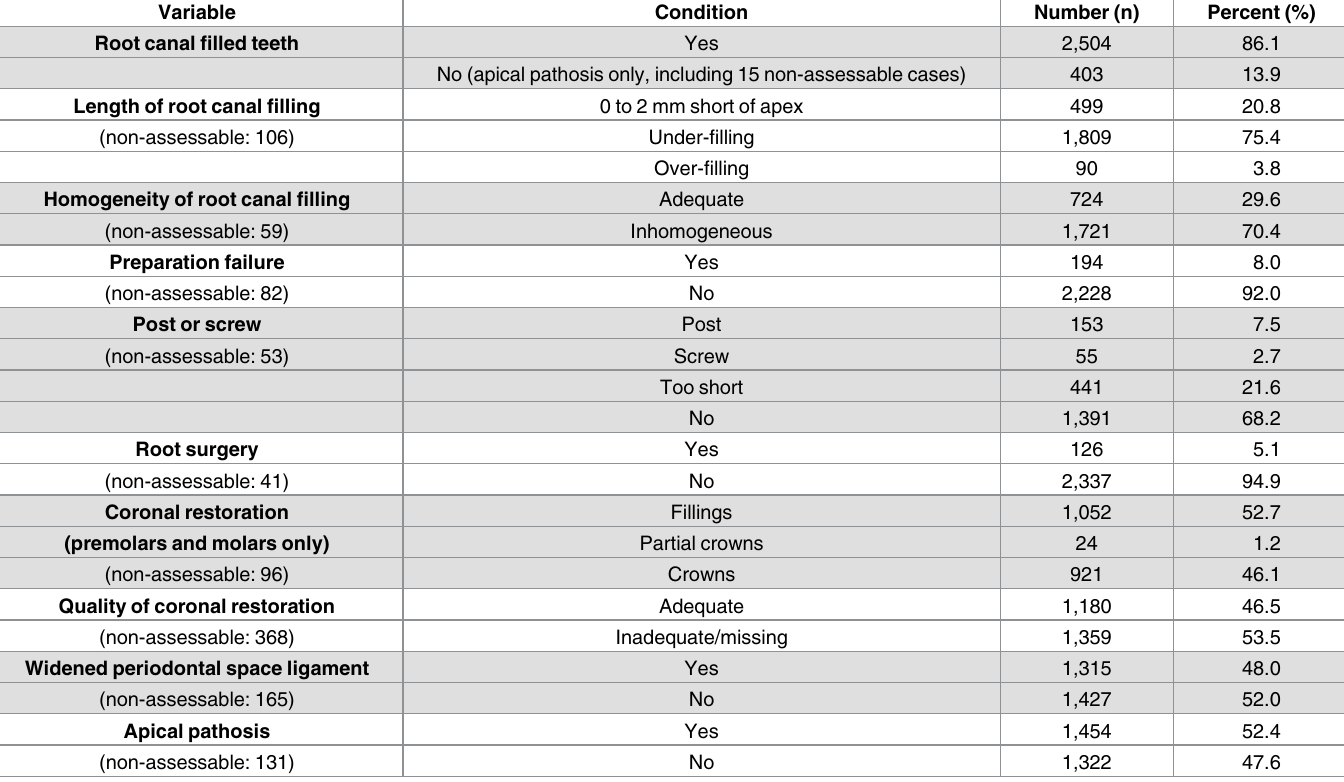
Table 3. Distribution of evaluated variables with root canal filled teeth (descriptive statistics including non-assessable